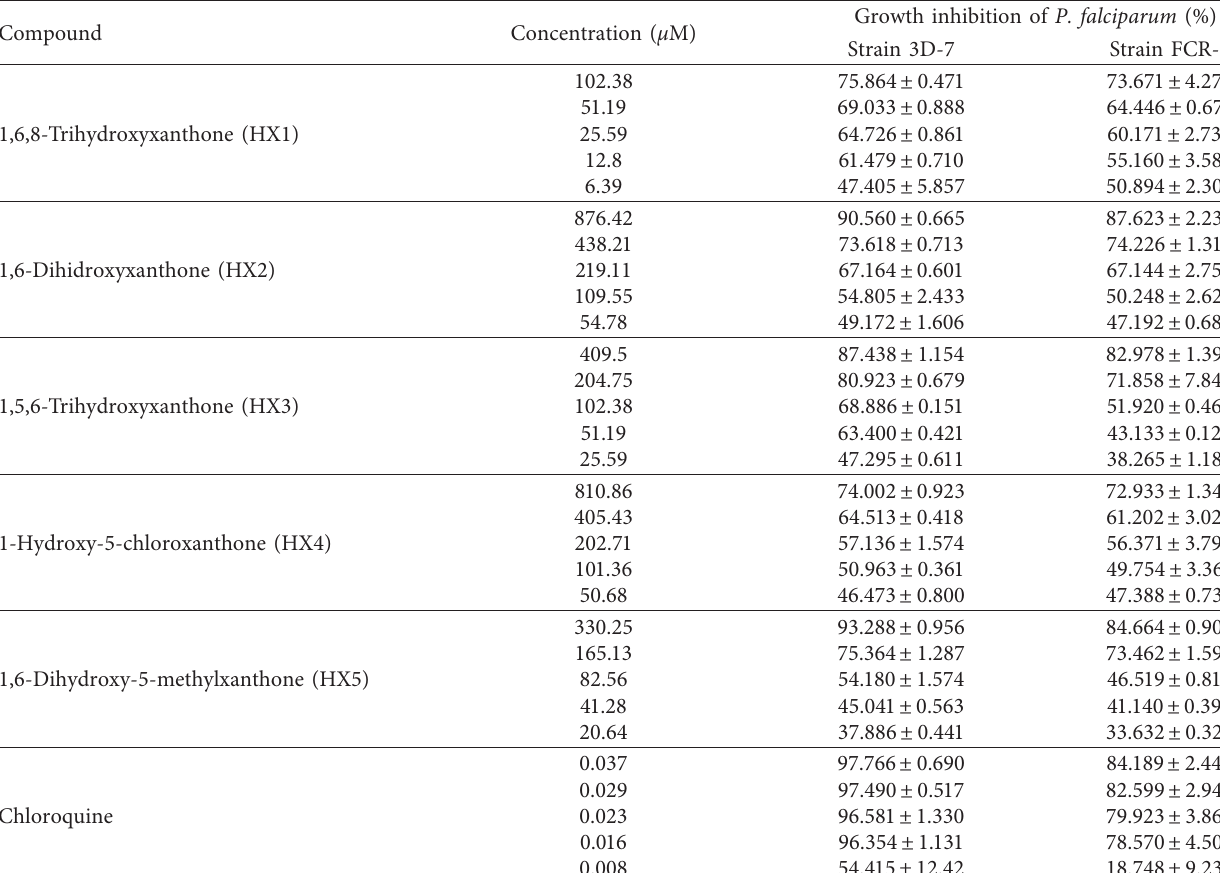
Table 1: The percentage of Plasmodium growth inhibition of hydroxyxanthone derivatives and chloroquine on P. falciparum 3D-7 and FCR-3.